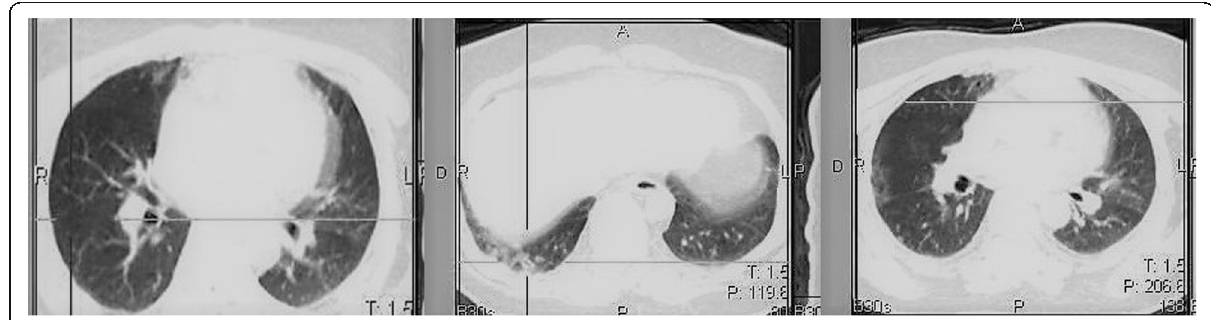
Fig. 4 Axial CT images in different slices showing ground glass opacities in the right lung on the left and right images, with the middle image showing linear consolidation in the right lung. Note the predominant peripheral